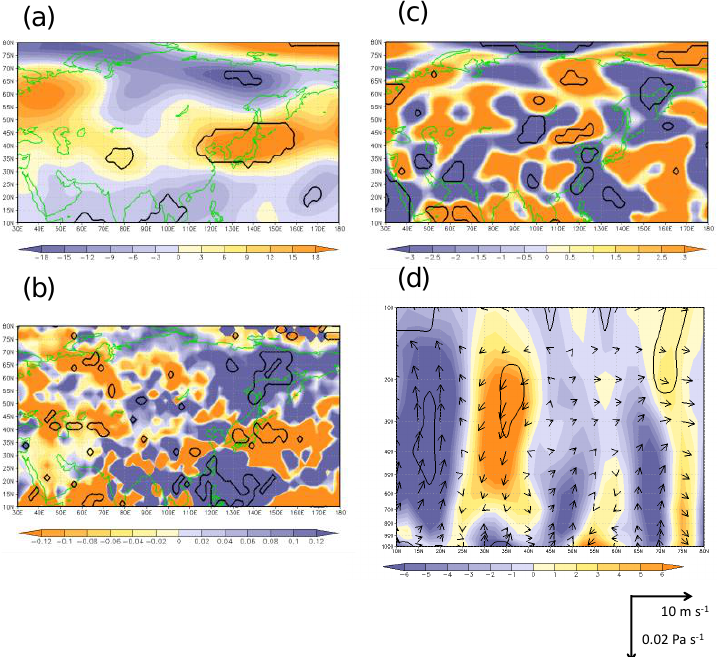
Figure 6. Composite differences in ( a ) geopotential height (in m) at 500 hPa, ( b ) precipitation (in mm day −1 ), and ( c ) vertical p-velocity (in 10 −3 Pa s −1 ) at 500 hPa between hot and cool summer years in NJJ. ( d ) Latitude-pressure cross-section of the composite differences in vertical p-velocity (10 −3 Pa s −1 ) between hot and cool summer years in NJJ at 140° E. Vectors show the composite differences in meridional-vertical flow (see legend for units). The borders of regions that reached a significance of 95% are shown with thick lines.